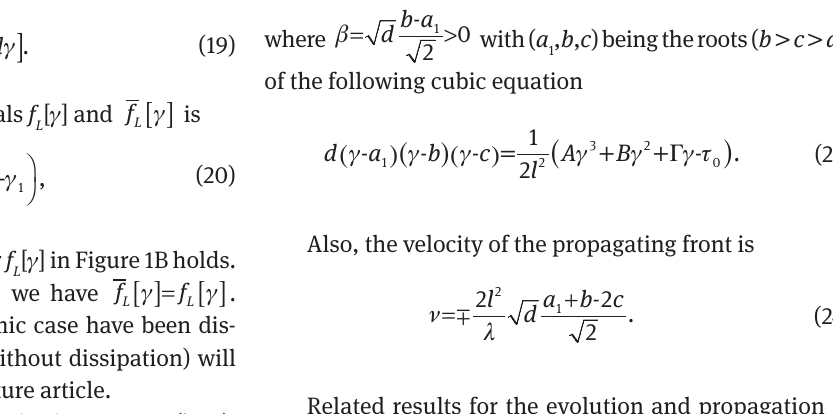
a fluctuating strain nucleus at the boundary are given in Figure 3 . The graphs of the kink profiles for t = 0 and t = 0.05 are shown in Figure 3A, whereas the graph of the strain nucleus at the boundary and the propagat- ing kink is shown in Figure 3B. The values of the model = 0.018, 2 l 2 = 10 -6 , parameters are: A = 1, B = -1, Γ = 0.27, τ 0 λ = 7 × 10 -5 and υ ≈ -1. The propagation velocity has a minus sign because the kink is traveling to the right. We have (